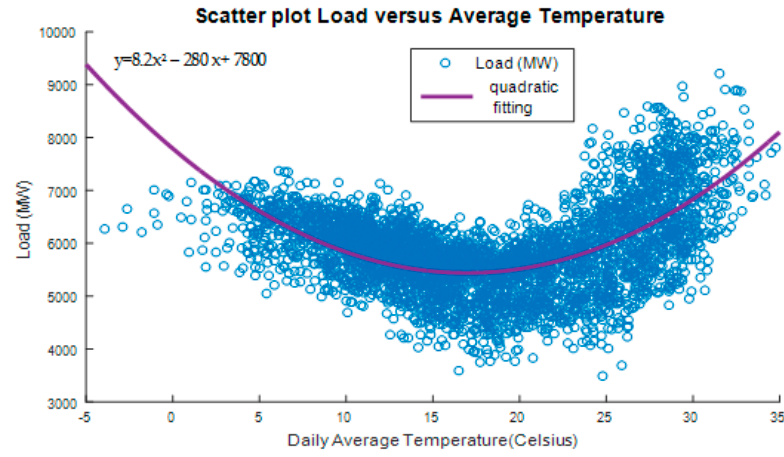
Figure 5. The parabolic variation of average temperature in Greece with load.